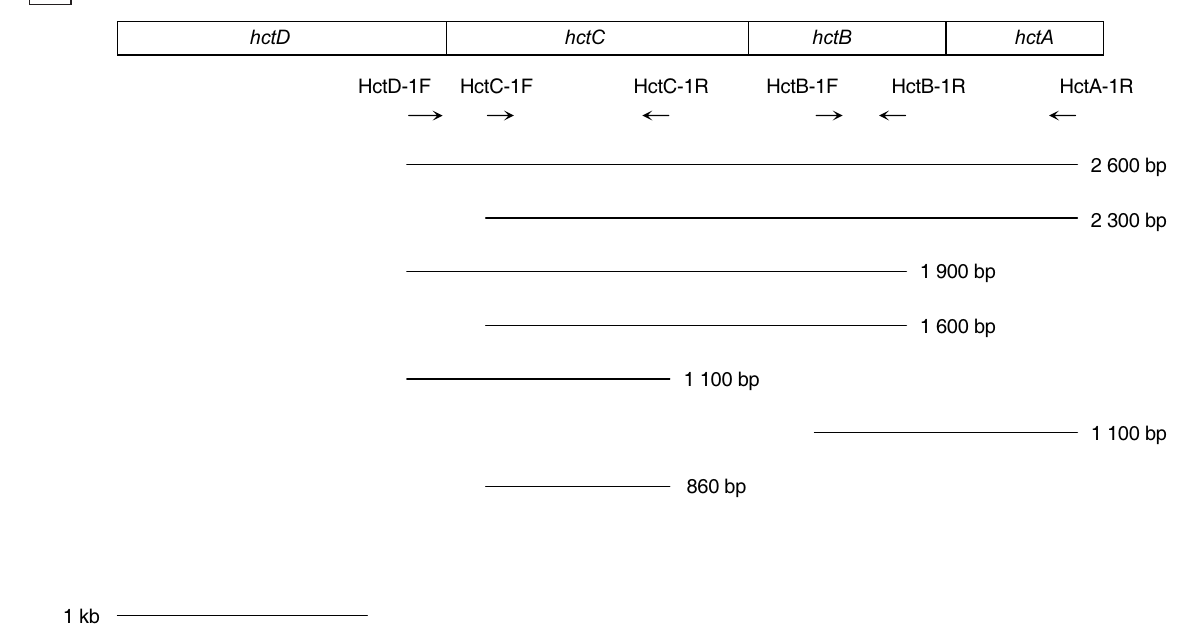
FIG. 1 A Amplification of segments of the H. paragallinarum capsule transport gene region The different degenerate oligonucleotides were used in the following combinations: HctD-1F & HctA-1R (lane 1), HctC-1F & HctA-1R (lane 2), HctD-1F & HctB-1R (lane 3), HctC-1F & HctB-1R (lane 4), HctD-1F & HctC-1R (lane 5), HctB-1F & HctA-1R (lane 6) and HctC-1F & HctC-1R (lane 7) B Schematic representation of the proposed H. paragallinarum transport gene region indicating the relative positions of the degenerate oligonucleotides used in Fig.